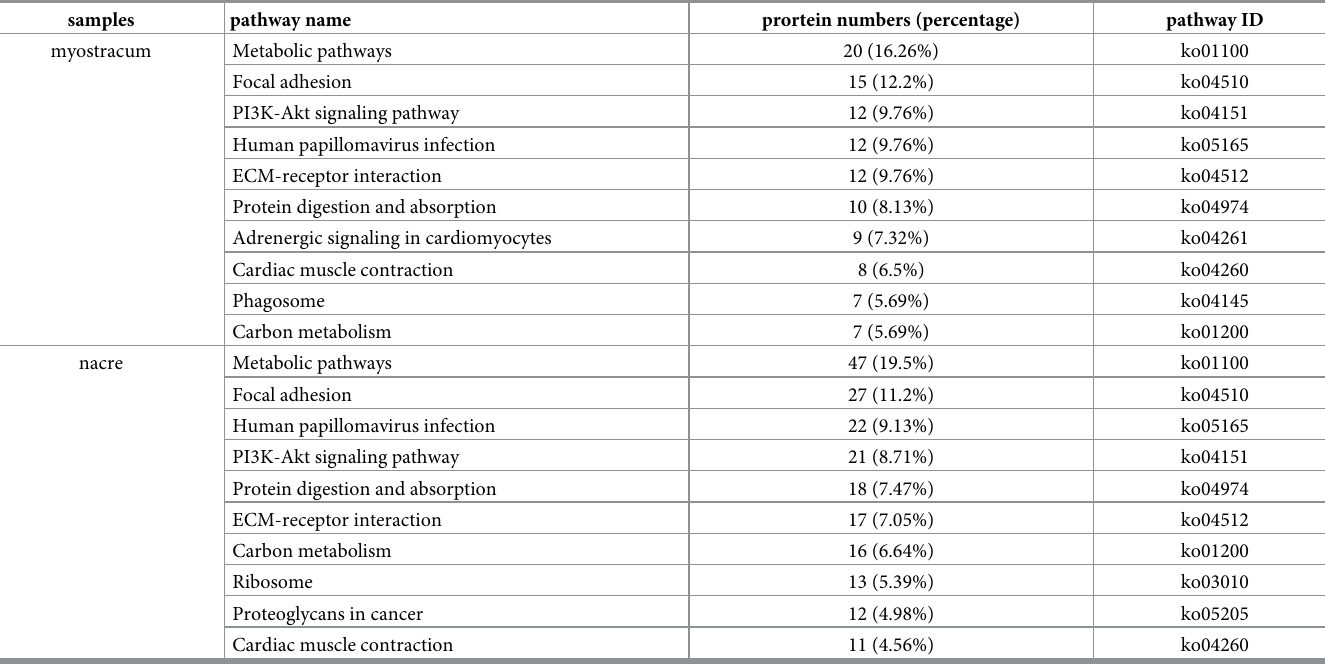
Table 3. The top 10 KEGG pathways of the identified proteins from the nacre and the myostracum layer of P . viridis